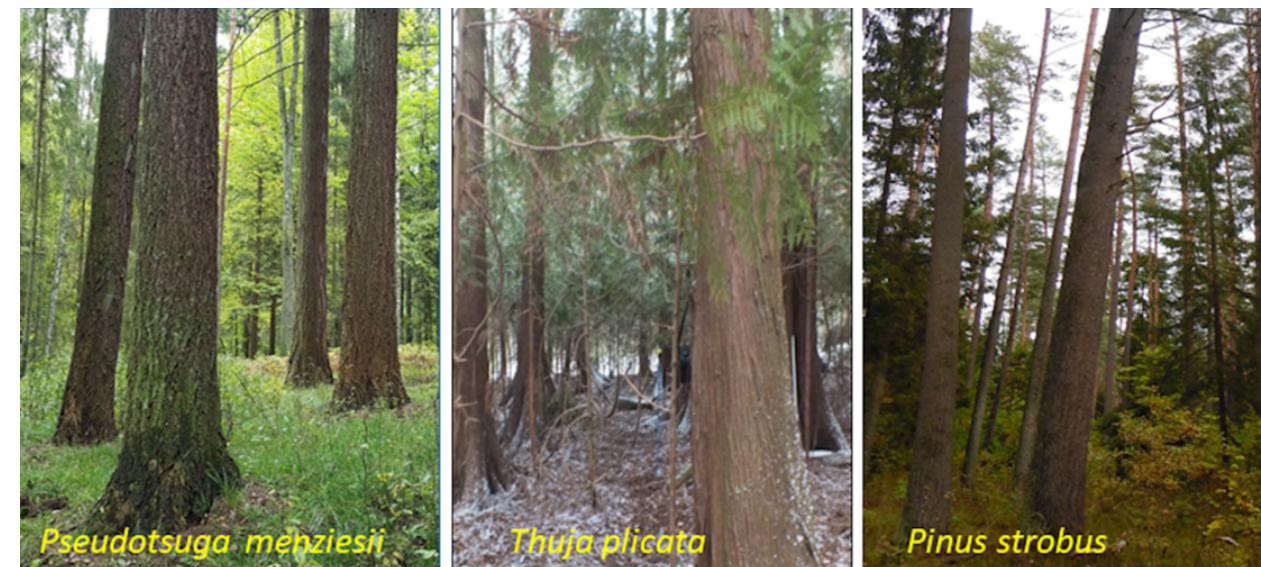
Figure 1 Representative pictures of the studied stands: Three most common nonnative species in Warmia.